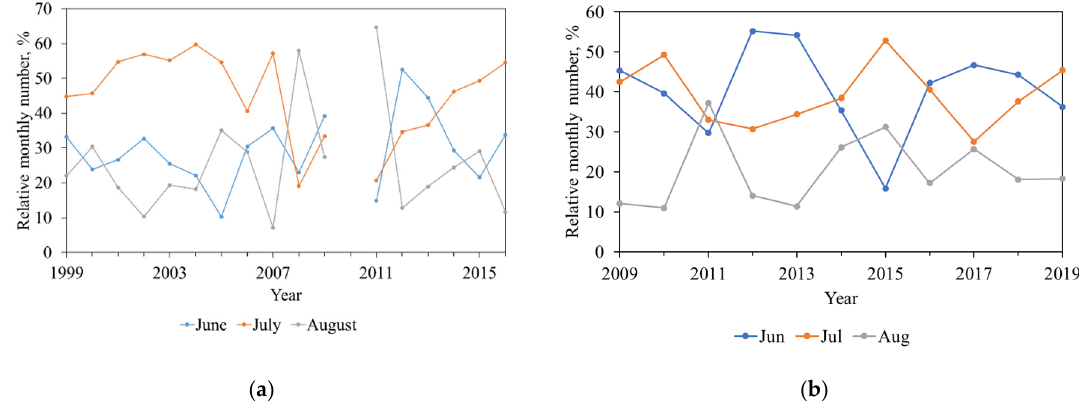
Figure 4. Relative monthly number by the data of ( a ) lightning direction finder (1200 km around Yakutsk), ( b ) WWLLN (56–74 ◦ N, 105–160 ◦ E).